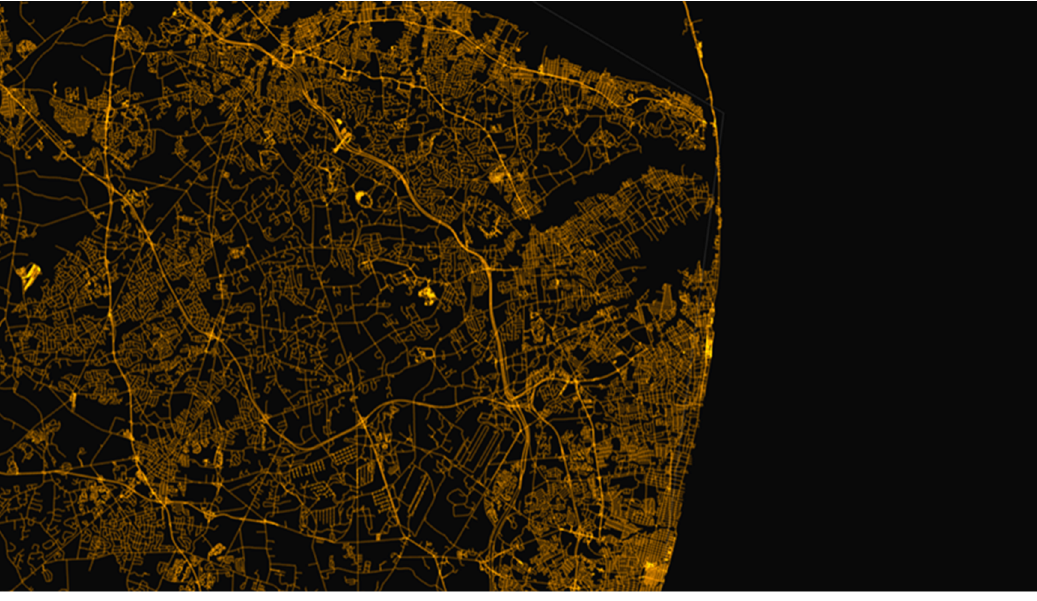
Figure 2. The urban map of Ningde city.